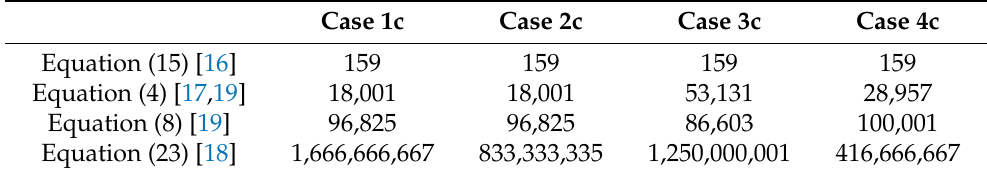
Table 8. Summary of number of integration